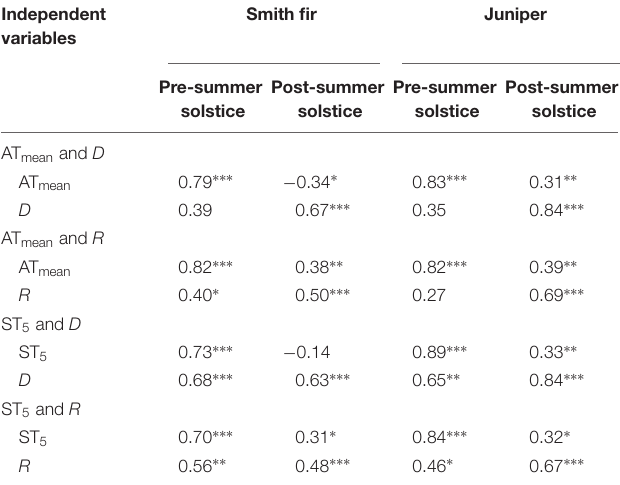
TABLE 3 | Partial correlation coefficients of multiple linear regressions of normalized daily sum sap flow density (normalized F d ) vs. temperature [mean soil temperature at 5 cm (ST 5 ) and mean air temperature (AT mean )] and atmospheric evaporative demand [vapor pressure deficit ( D ) and solar radiation ( R )] variables across tree species and growing seasons.